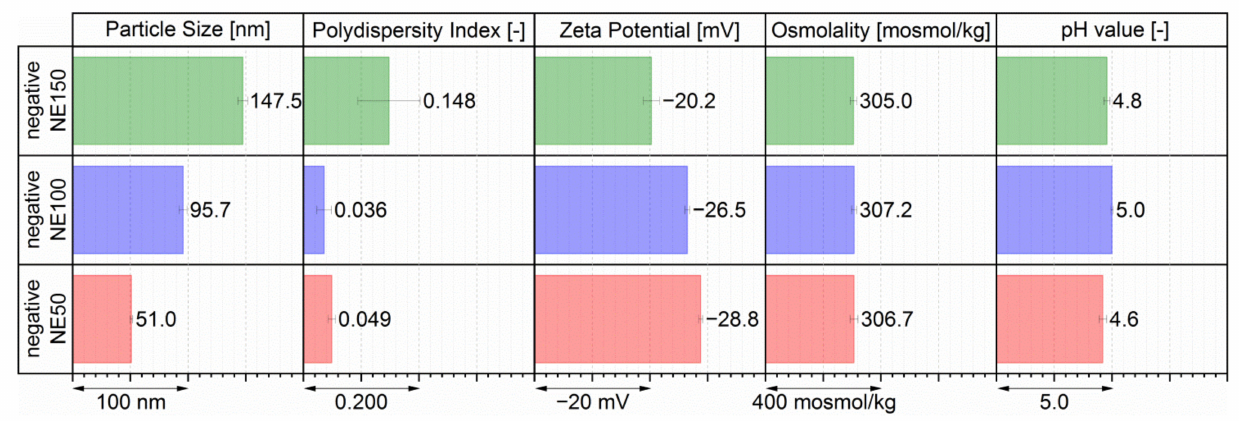
Figure 4. Physicochemical properties of the three chosen isotonic, negatively surface-charged na- noemulsions for the animal trials, determined by three individual produced